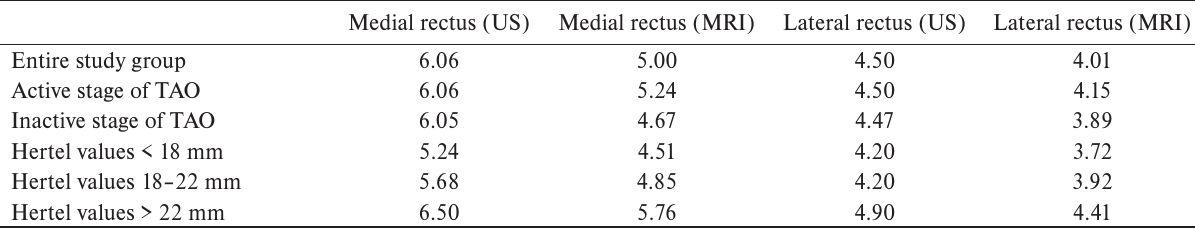
Table 2. Median values of the largest diameter of the medial and lateral rectus muscles obtained by ultrasonic measurement (US) and measurement on MRI scans in different subgroups, all given in mm. Medial rectus (US)